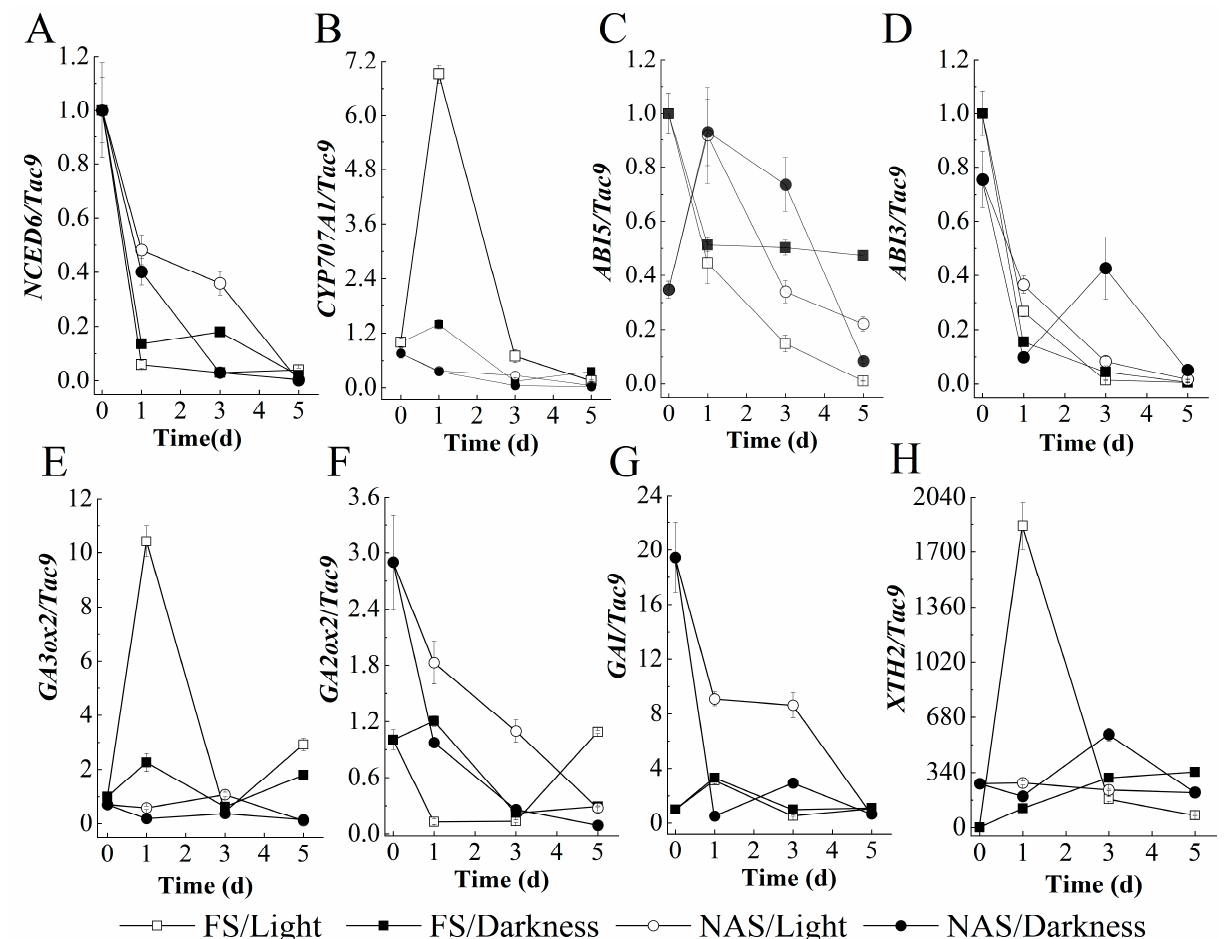
Figure 4. Expression levels of genes involved in ABA (A-D) or GA (E-H) metabolism or signal in FS or NAS during germination.